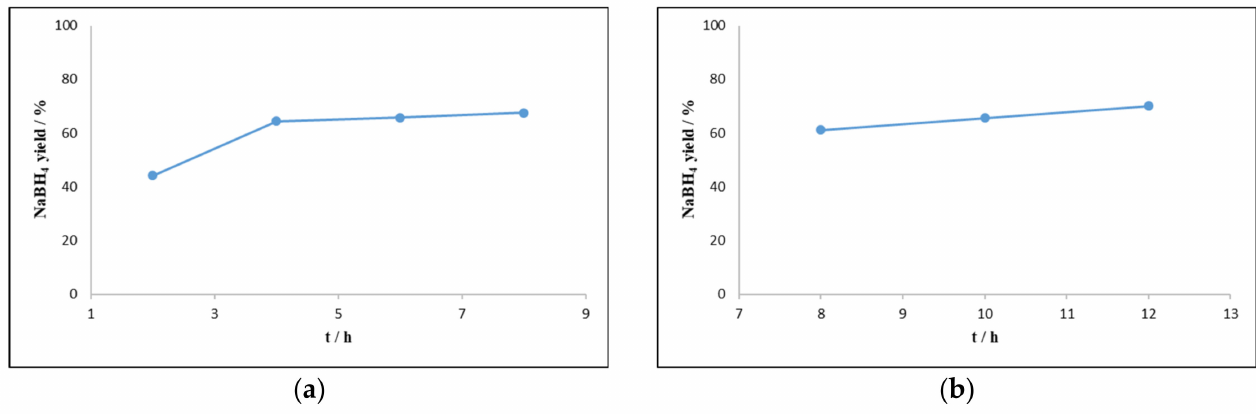
Figure 10. Values of NaBH 4 yield vs. t without ( a ) and with ( b ) CH 3 OH. Adapted from